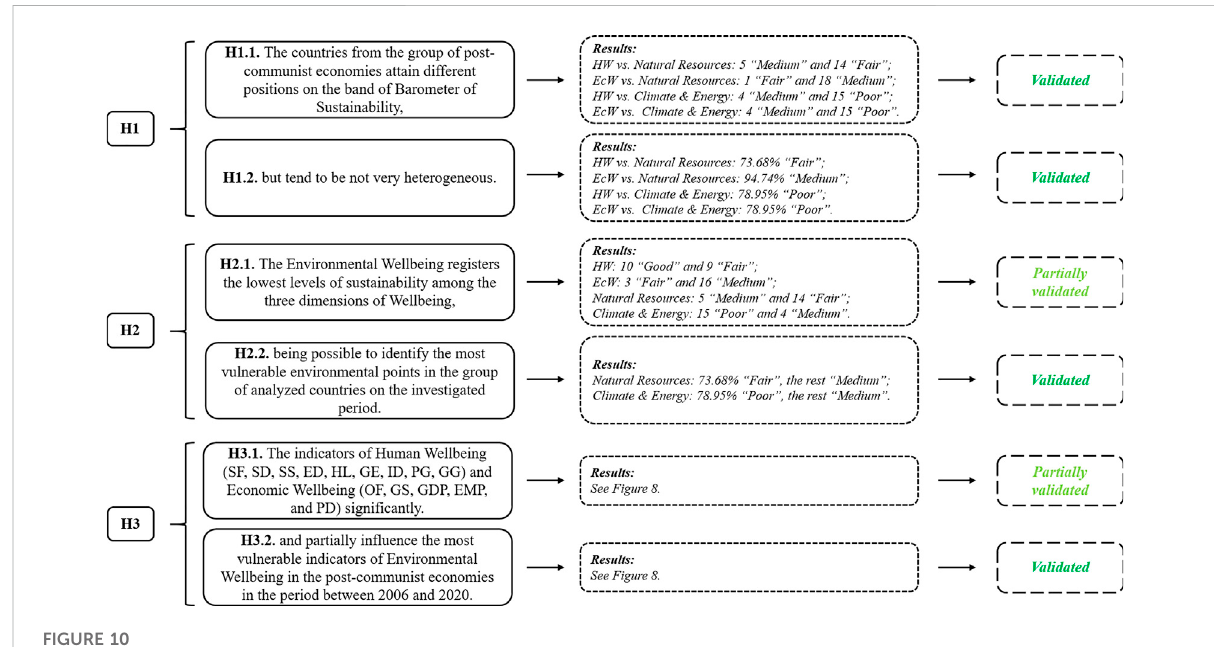
FIGURE 10 Overview in regard to the validation of the main hypothesis of the